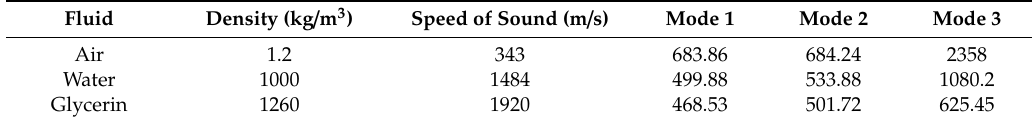
Table 4. Natural frequency for the probe of different fluids in (Hz).